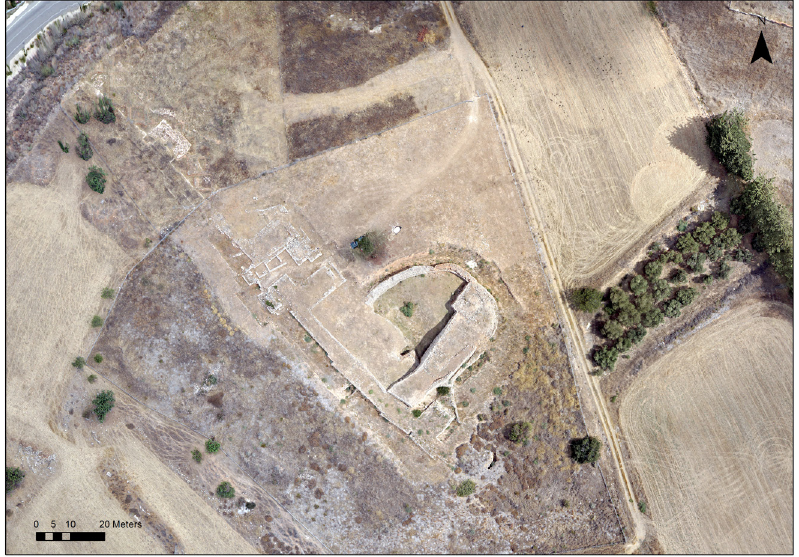
Figure 17. UAV Orthphoto of the Marchello rampart and the ditch (north side) where royal inscriptions and statues were buried. Drafted by A. Agapiou